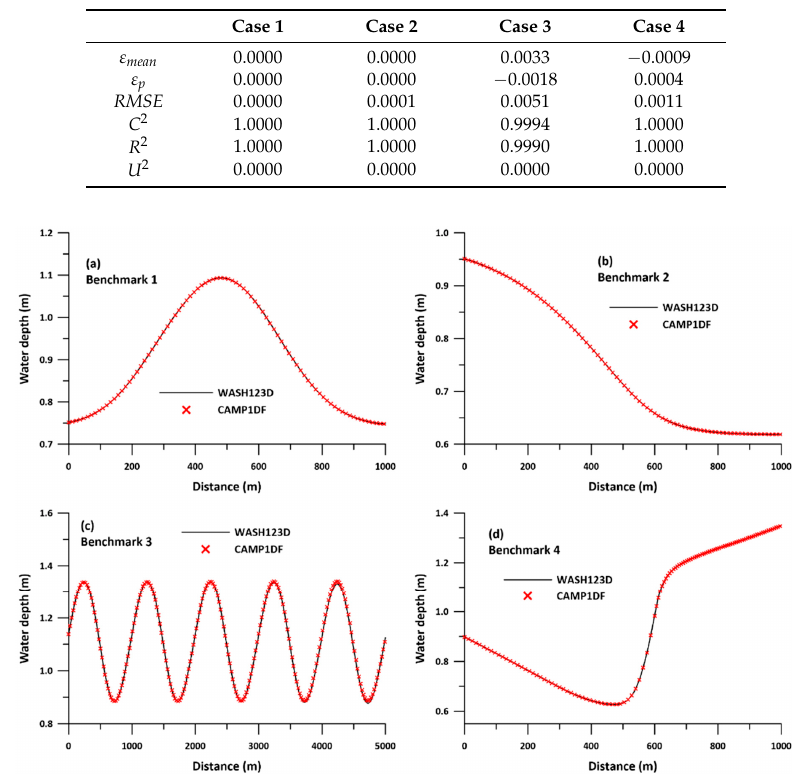
Figure 4. Calibration result of the diffusion wave (DIW) of ( a ) benchmark 1, ( b ) benchmark 2, ( c ) benchmark 3, and ( d ) benchmark 4 of MacDonald et al. (1997) [30].